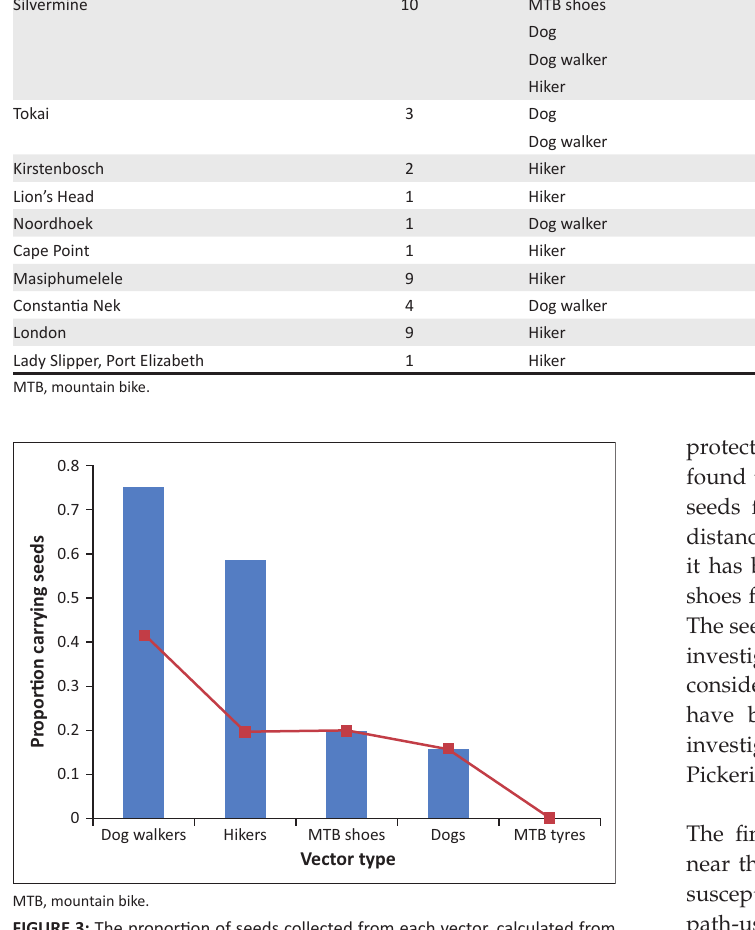
TABLE 1: The total number and morph of seeds collected from tourists (cyclists, dog walkers and hikers) entering the Silvermine section of the Table Mountain National Park, and their potential source of origin. Last place where shoes were worn/dogs walked